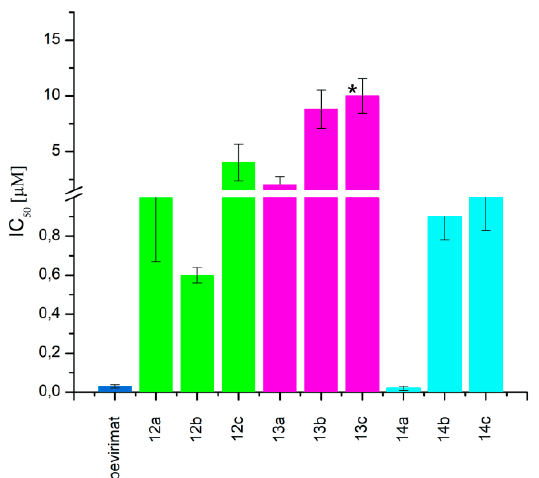
Figure 4. Anti-HIV-1 activity (IC 50 ) of 3-carboxyacylbetulinic acids divided into groups of corresponding phosphorus derivatives (30-phosphate: 12a – c ; 29-phosphonate: 13a – c ; 30- phosphonate: 14a – c ) and BVM used as a reference. (* the mean measuring error of absorbance at the highest concentration.)